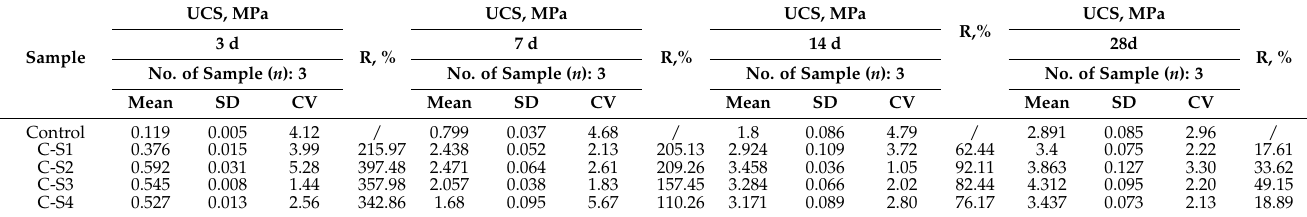
Table 3. The statistical analysis of UCS results.